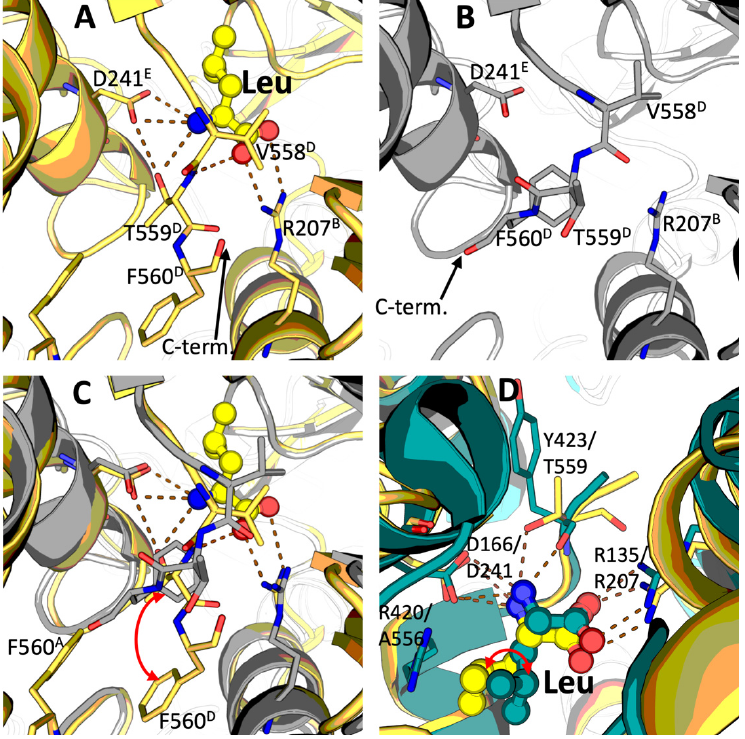
Figure 2. Binding of leucine by bovine GDH. The superscripts of the indicated residues denote belonging of the residues to one of the six monomers within the lower (A, B, C) and upper (D, E, F) trimers, as shown in Figure 1. ( A )—Structure of leucine (Leu) binding site in the ternary GDH complex with leucine and ADP (PDB 8AR7; the cartoon and carbon atoms are in yellow, while dashed lines indicate the H-bonds). ( B )—Structure of leucine binding site in the binary complex of GDH with ADP (PDB 8AR8; the cartoon and carbon atoms are in gray). The leucine binding site is shown at the interface of chains B, D and E of the GDH hexamer, as defined in Figure 1. The chain D is traced until residue F560 in both complexes; in the binary GDH ∙ ADP complex, the GDH C-terminal end assumes an equivalent conformation to the one observed in other GDH structures in the open form (e.g., PDB 3JCZ or 7VDA [10,14]). ( C )—Conformational changes in the leucine binding site upon binding of the activator (images ( A ) and ( B ) are superposed with the main shift of F560 indicated by the red arrow). ( D )—Comparison of the leucine binding sites in the bovine (yellow) and T. thermophilus (teal) GDH structures. The different conformation of the leucine side chain in the complexes of bacterial and mammalian GDH is indicated by the red arrow. Chain A of PDB 3AOE (GdhB) is used for the bacterial GDH model. The conformation of bound leucine in other subunits, including those encoded by gdhA , is similar [15]. A bound leucine molecule is observed in all the six equivalent sites within the mam- malian GDH hexamer. Throughout the text, belonging of the considered residues to the monomers A, B, C, D, E, F, shown in Figure 1, is defined by the corresponding super- scripts. Leucine binds at the contact area between the three different subunits, involving those from the opposite trimers forming the GDH hexamer. That is, the leucine binding site shown in Figure 2 is formed by the subunits B, E and D (Figure 1). While the R207 B guanidinium group makes a salt bridge with the leucine carboxyl group, the D241 E car- boxyl group from another subunit binds the leucine amino group, which in turn interacts also with the hydroxyl group of T559 D located at the C-terminal end of the third subunit.